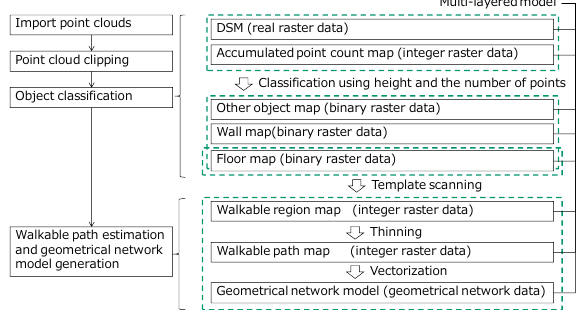
Figure 1. Geometrical network model generation